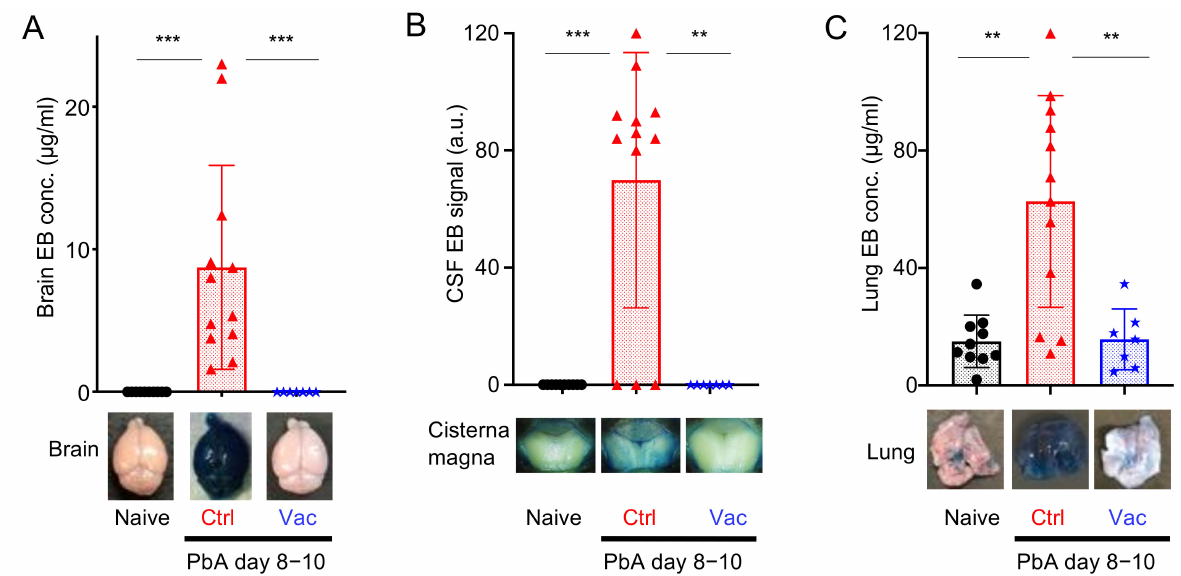
Figure 4. Plasmodium yoelii 17XNL live vaccination (Vac) protected the blood–organ barrier from P. berghei ANKA strain (PbA) infection. ( A ) Brain Evans blue (EB) concentration indicating the integrity of the blood–brain barrier. ( B ) Cerebrospinal fluid (CSF) EB signal indicating the integrity of the blood–cerebrospinal fluid barrier. ( C ) Lung EB concentration indicating the integrity of the blood–air barrier (alveolar–capillary barrier). Each symbol represents one mouse. Representative photographs of the EB-stained and perfused brain, cisterna magna, and lung from naive (N = 10; black circle), control (Ctrl; N = 12; red triangle), and Vac (N = 7; blue star) mice on days 8–10 following challenge infection with PbA are shown at the bottom of each figure. Data were pooled from 3 independent experiments. Data represent the mean ± standard deviation (SD). ** p < 0.01; *** p < 0.001. p values were determined by two-tailed Student’s t -test or Mann–Whitney